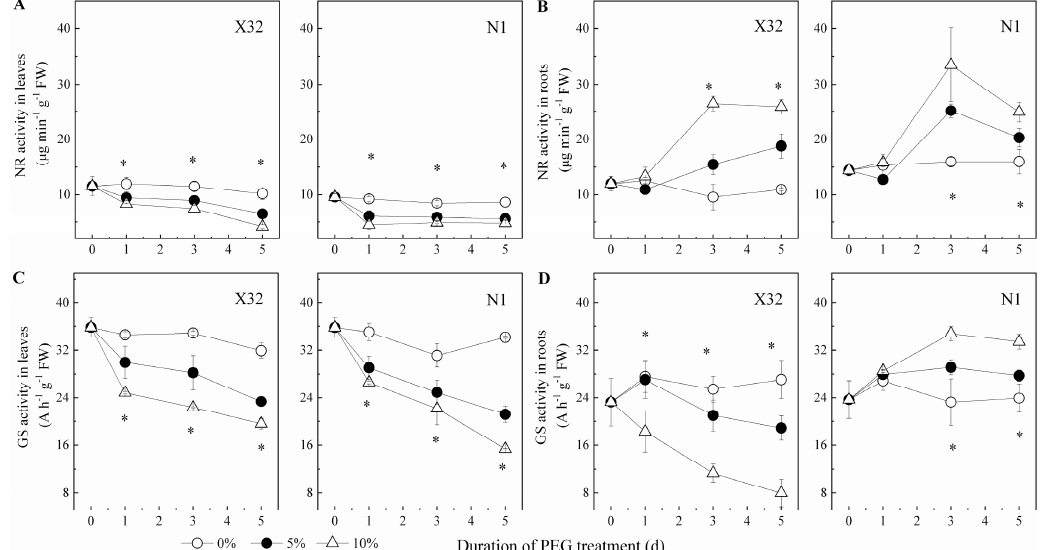
Figure 10. Effects of drought stress on NR activity and GS activity in leaves ( A , C ) and roots ( B , D ) of the sweet potato. X32 and N1 represent Xushu 32 and Ningzishu 1, respectively. The stages labeled with an asterisk (*) indicate significant differences ( p < 0.05) among the three PEG levels in the figure.